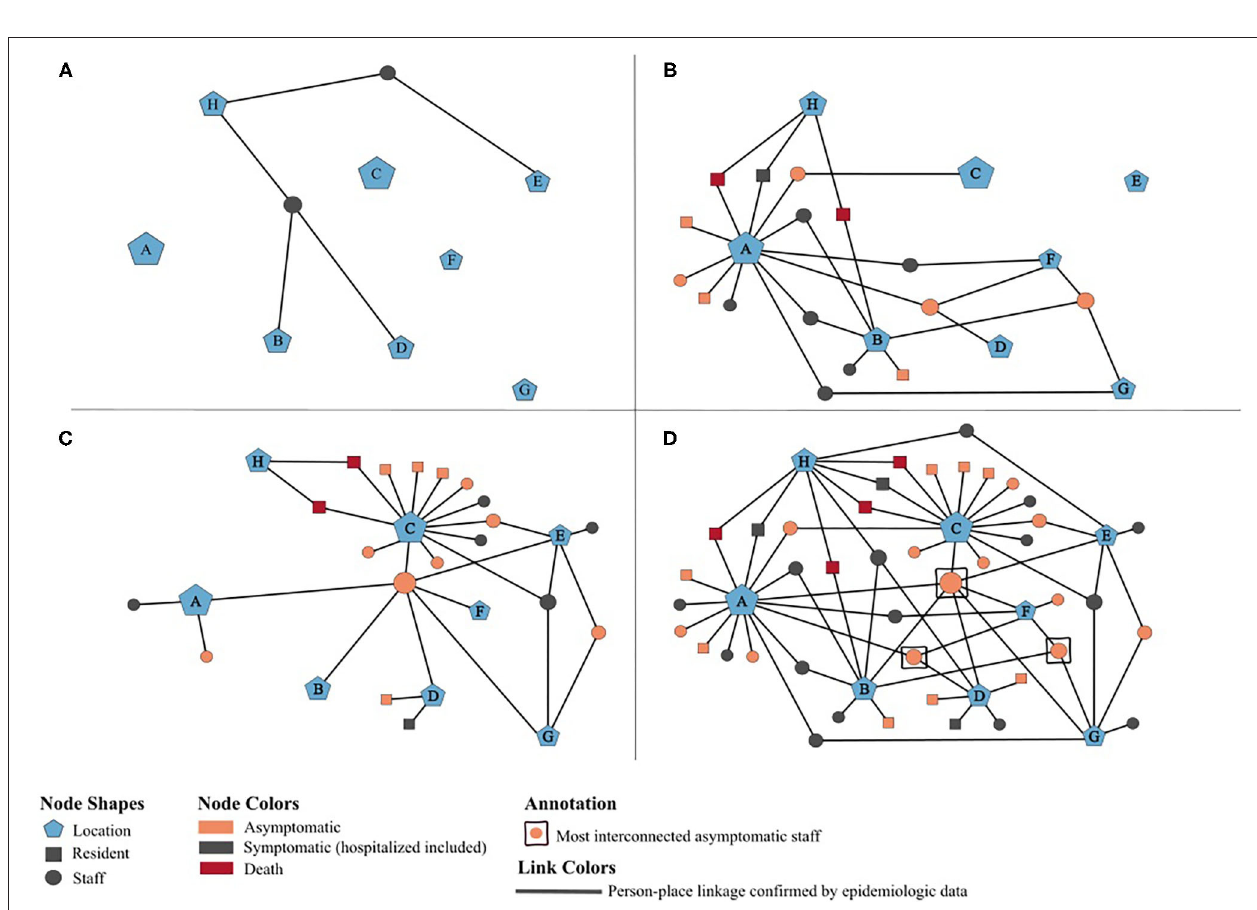
FIGURE 1 | from staff and red nodes represent sequences from residents. Square shaped nodes represent the household contact of an infected staff and triangular shaped nodes represent healthcare workers. Genomes have been published to GISAID. EPI_ISL_694009-023, 025–040, 228, 231–235, 237–239, 241–242, 244, 318, 320, 322, 324, 328, 330, 335.341, 342, 345, 350, 351, 355, 378, 380, 381, 387, 389, 391, 398, 399, 434, 437, 442, 451, 455, 601, 607, 914212, 299. All Arizona samples in the tree have the D614G mutation.